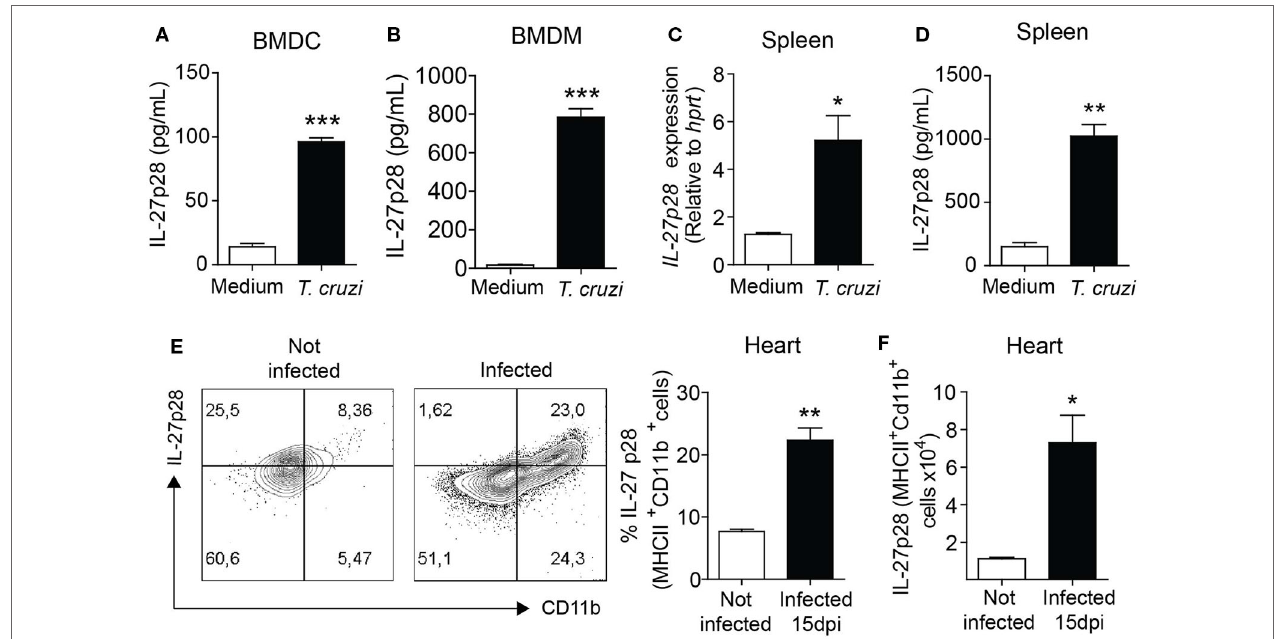
FigUre 4 | IL-27 is highly produced by myeloid cells following infection with Trypanosoma cruzi . (a,B) Dendritic cells and macrophages were differentiated from bone marrows of naïve wild-type (WT) mice and stimulated with medium or T. cruzi trypomastigotes (MOI 3:1). After 48 h, supernatant was collected and IL-27p28 levels were assessed by ELISA. (c,D) Splenocytes from naïve WT were cultured with medium or trypomastigotes (MOI = 3:1) for 6 or 48 h for mRNA or protein quantification of IL-27. (e,F) Intracellular expression of IL-27p28 by MHCII + CD11b + myeloid cells 15 days after T. cruzi infection. Hearts of the WT mice infected or not were collected and digested with a cocktail of liberase TL (Roche). Cells were re-stimulated in vitro with PMA/ionomycin for 6 h and subjected to extracellular staining for MHCII and CD11b and intracellular staining for IL-27p28. Data are expressed as representative dot plots, percentage, and absolute number of IL-27 + MHCII + CD11b + cells. Data shown are mean ± SEM of cultured cells in triplicates and from five mice per group and are representative of two independent